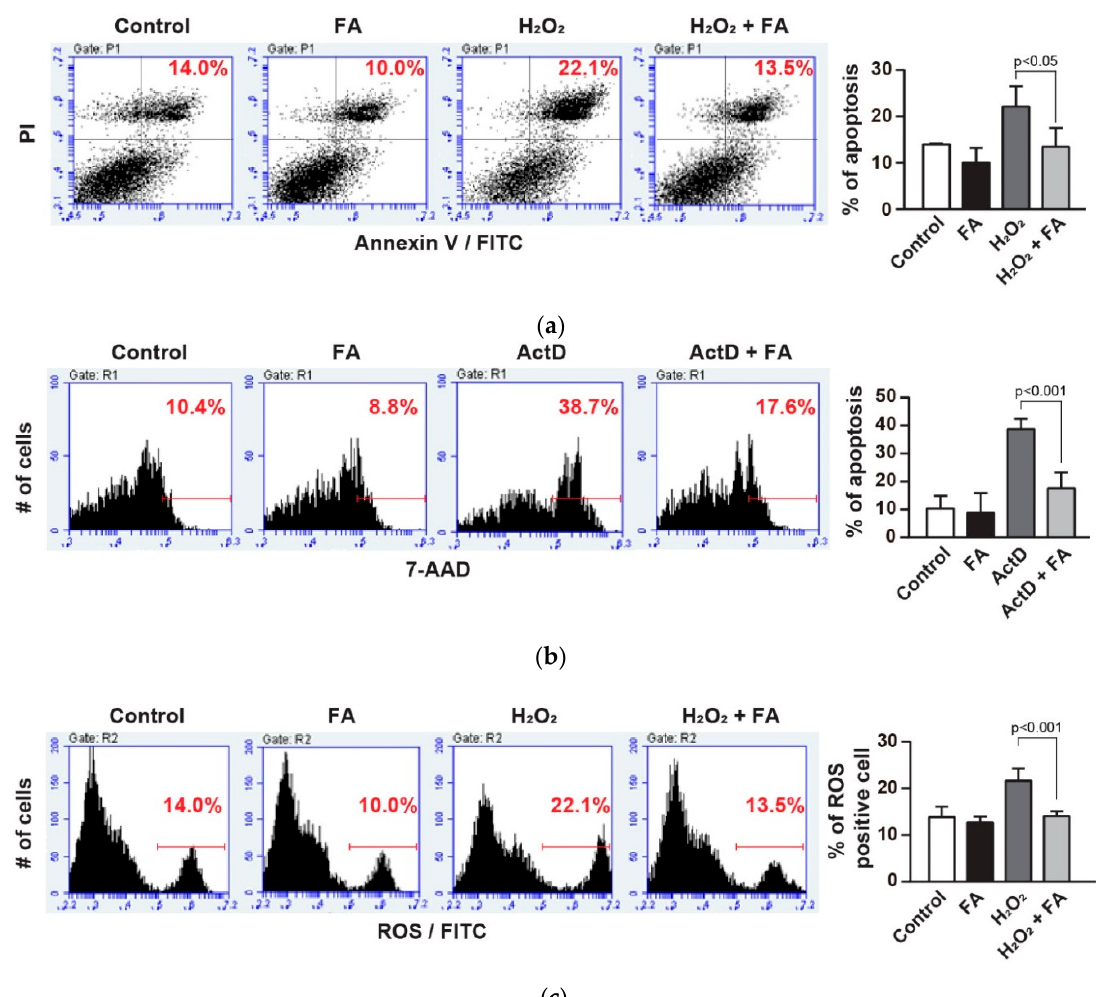
Figure 1. Effect of ferulic acid (FA) against oxidative stress in PC12 cells. ( a ) PC12 cells were pretreated with FA (40 µM) overnight and subsequently cultured cells in the absence or presence of H 2 O 2 (1 mM) for another 30 min. Cells were stained with Annexin V-FITC/PI to detect apoptotic cells (upper right quadrant) by flow cytometry. ( b ) PC12 cells were pretreated with FA (40 µM) overnight and subsequently cultured cells in the absence or presence of ActD (20 µM) for another 1 h. ActD-treated cells were stained with 7AAD for 10 min and subsequently analyzed by flow cytometry. ( c ) PC12 cells were pretreated with FA (40 µM) overnight and subsequently incubated with Amplite™ ROS Green for 1 h. Then, cells were cultured in the absence or presence of H 2 O 2 (1 mM) for another 30 min, and were analyzed by flow cytometry. Data represent the mean ± SD.